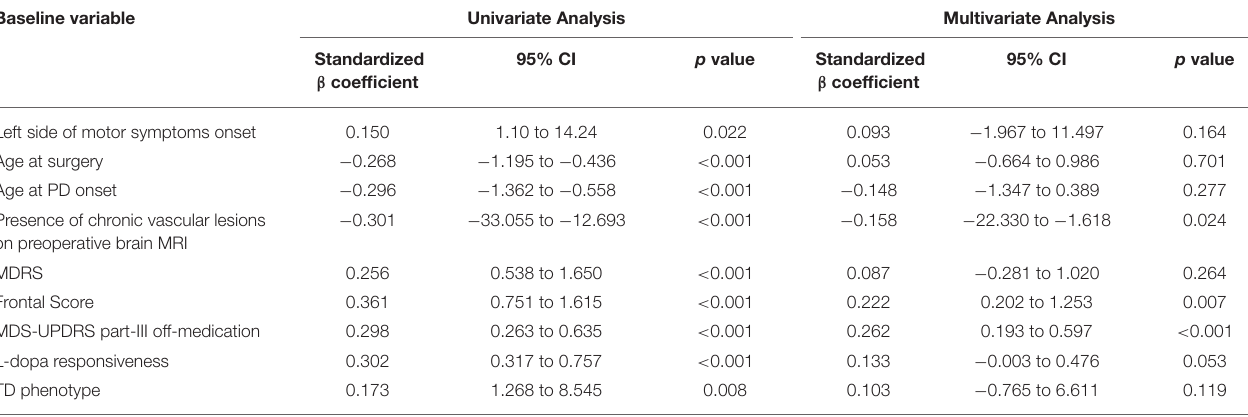
TABLE 3 | Preoperative predictive factors of motor outcome after STN-DBS ( n =